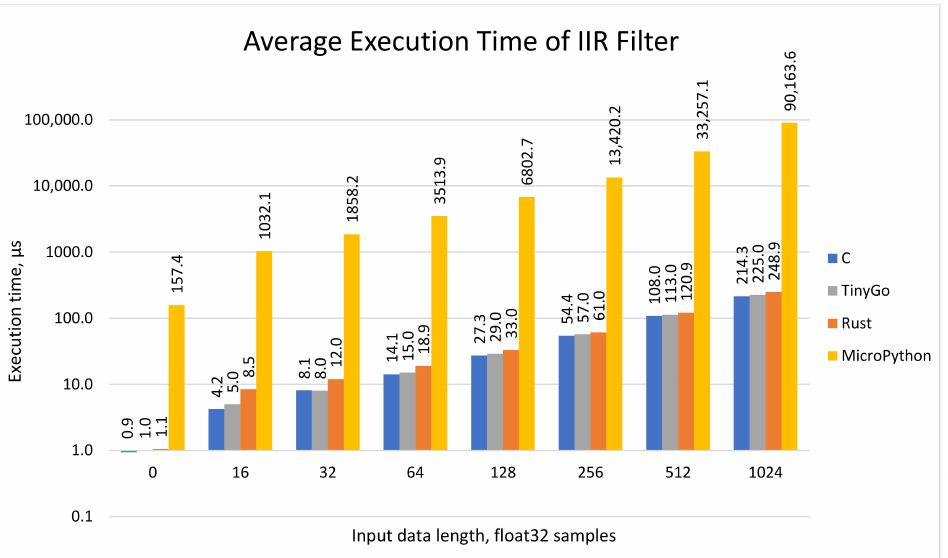
Figure 9. Average execution times of the IIR filter algorithm (please note the logarithmic time